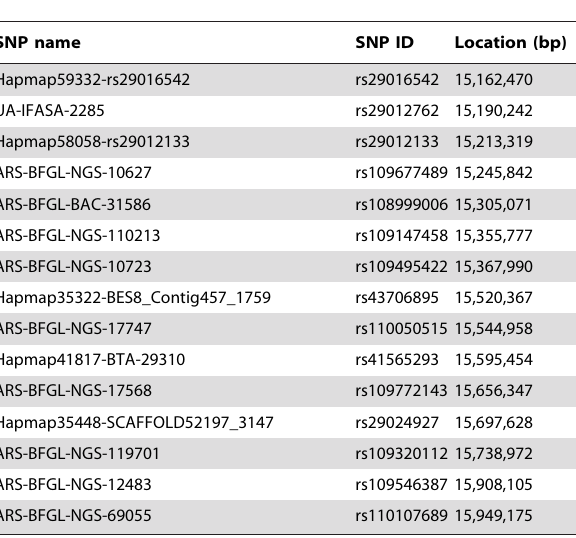
Table 1. The 15 SNP in the JH1 suspect region and their locations on the UMD 3.1